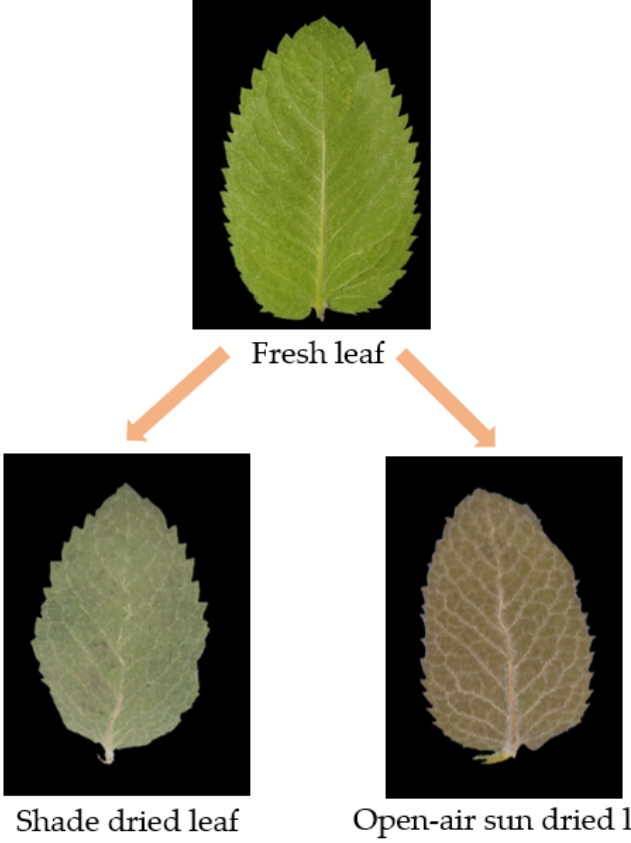
Figure 2. The images of the dorsal side (lower surface) of fresh and dried mint leaves.